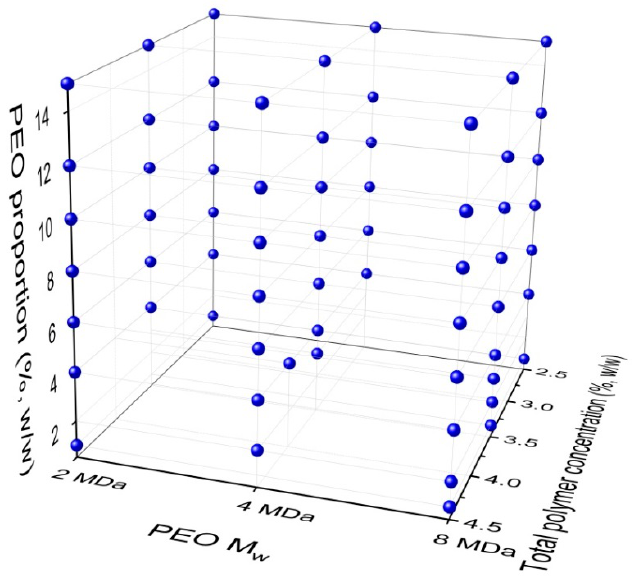
Figure 1. Three-dimensional representation of the experimental design space of the polymer-blend solution compositions for the nanofiber formation. The three components varied were: PEO M w ; total polymer (alginate plus PEO) concentration; and PEO proportion in the dry alginate–PEO polymer mix used for the polymer-blend solution.